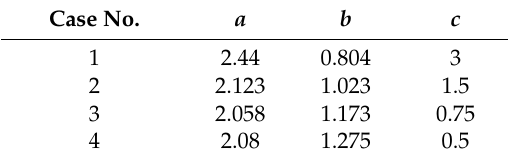
Table 7. Constants a , b , and c for Equations (24) and (25) based on Table 4. Case No.